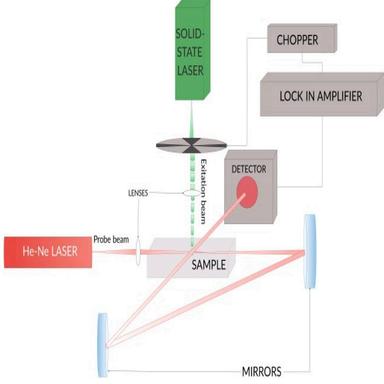
Scheme of the BDS experimental setup used in this study.